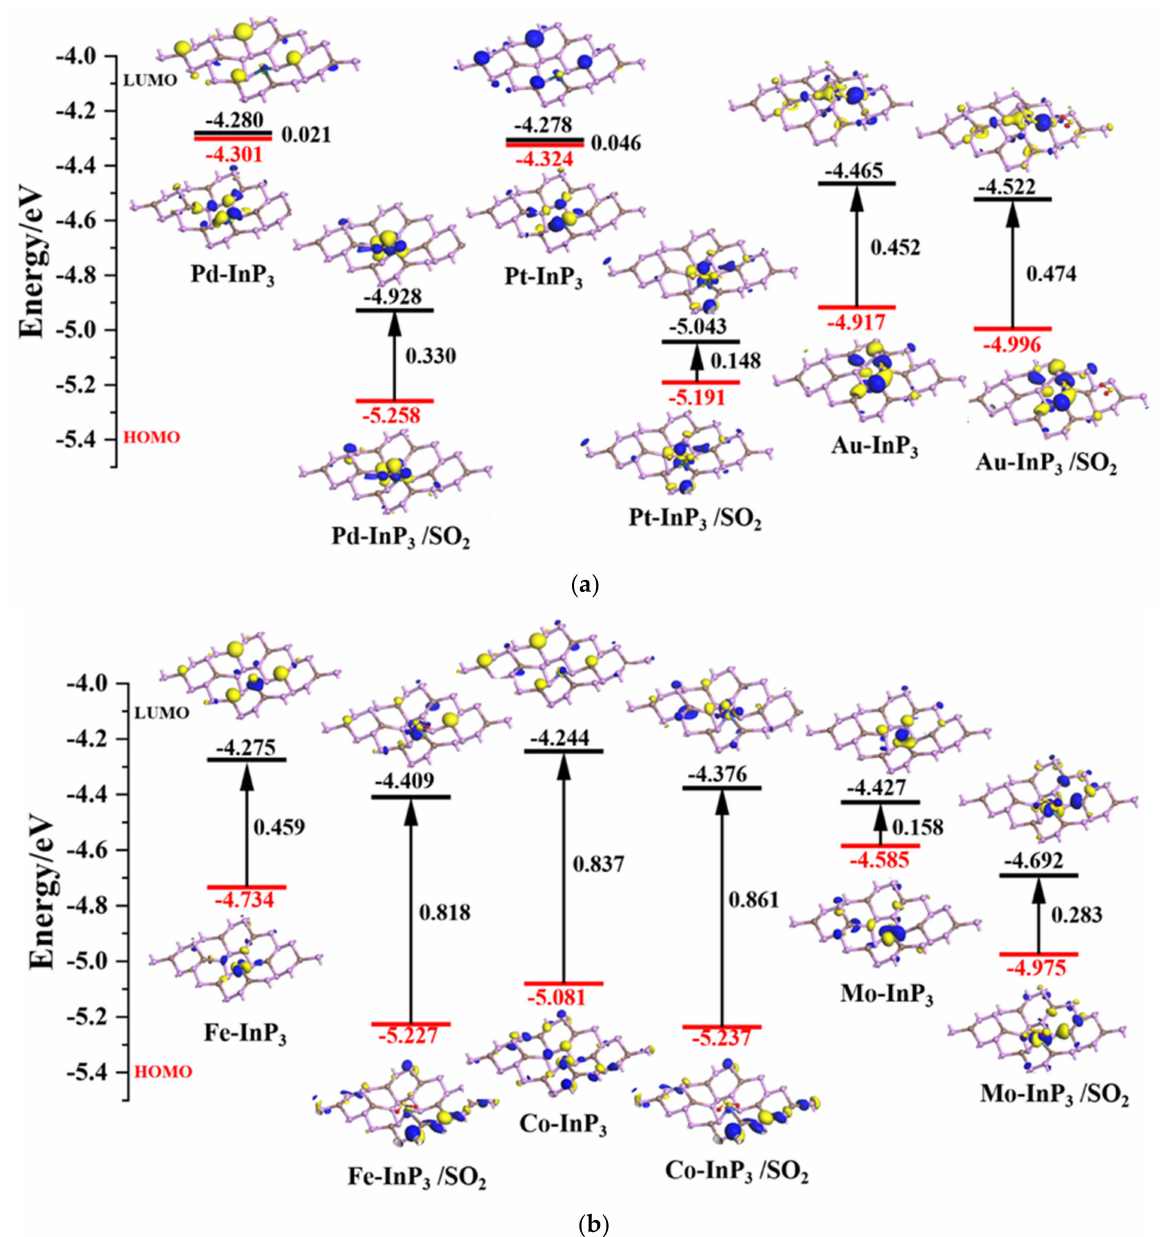
Figure 6. HOMO and LUMO distributions of TM-InP 3 monolayers and TM-InP 3 /SO 2 systems, ( a ) TM = Pd, Pt, Au, ( b ) TM = Fe, Co,